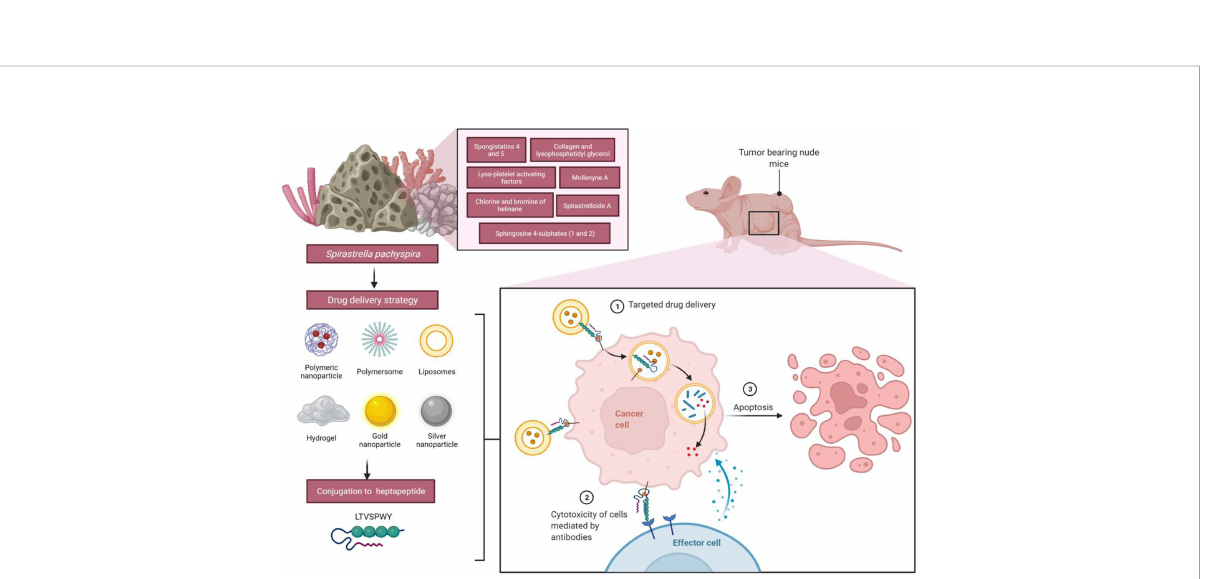
FIGURE 7 Future applications of liposomes functionalized with heptapeptide-loaded Spirastrella pachyspira extracts against breast cancer cells. The heptapeptide LTVSPWY has a high af fi nity for human mammary adenocarcinoma SK-BR3 cells; thus, it can be used to deliver bioactive compounds from Spirastrella pachyspira ’ s extract to cells for internalization, which may result in signi fi cant apoptosis when the effects are combined